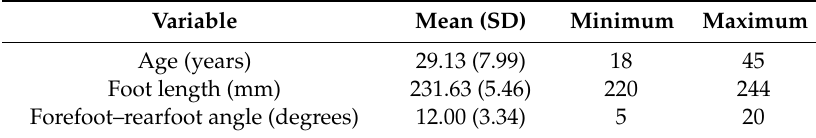
Table 1. Statistical summary (N = 102).